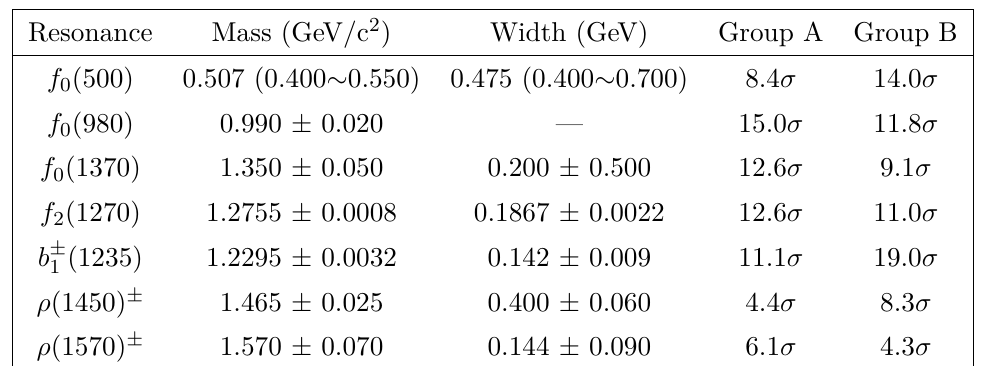
Table 2 . Masses and widths of the intermediate states and statistical significances of individual intermediate processes in group A and group B data sets.